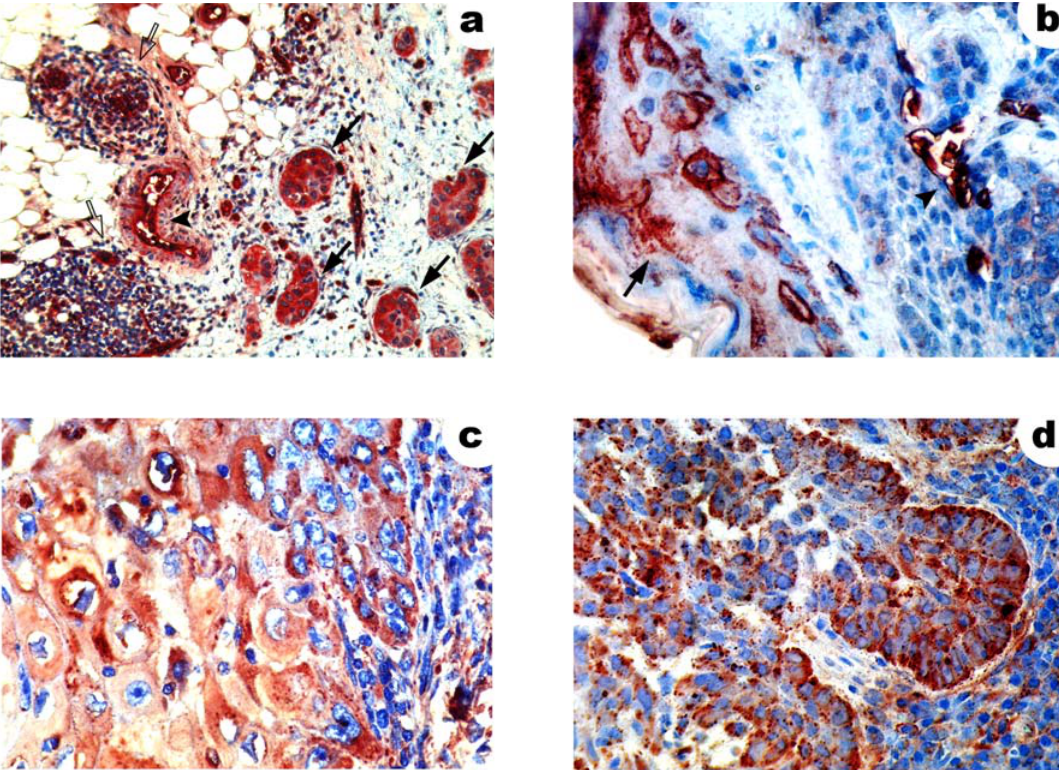
Fig. 2 Expression of HBGAs and LAMPs in skin carcinoma (biotin-streptavidin- peroxidase